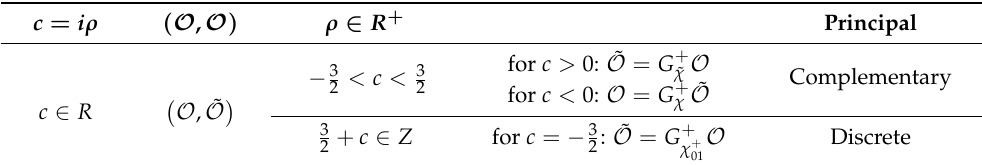
Table 1. Categories of the representations of SO ( 4,1 ) and the appropriate intertwining operators mentioned in the